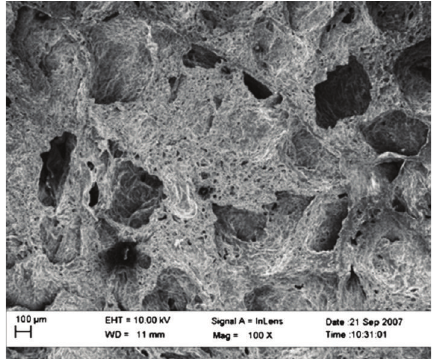
Figure 3: SEM image showing the macroscopic pore structure of a polyurethane foams coated with CNTs by EPD (deposition voltage: 20 V)